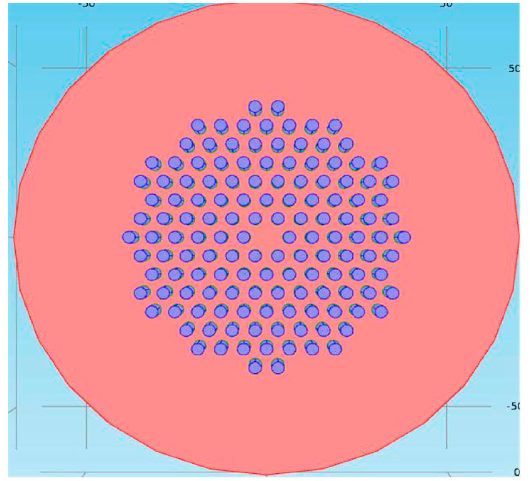
Figure 4. Schematic of the liquid-filled photonic crystal fiber (PCF) (the red region is PCF and blue region is toluene).